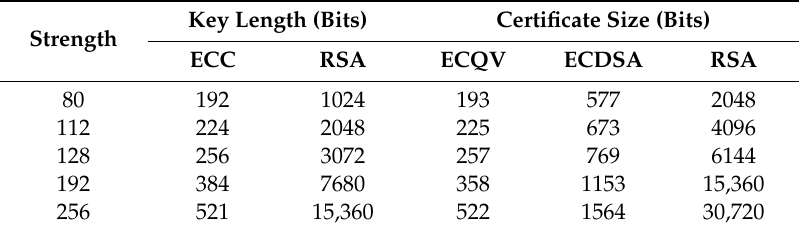
Table 2. A comparison of security strengths. ECQV, elliptic curve